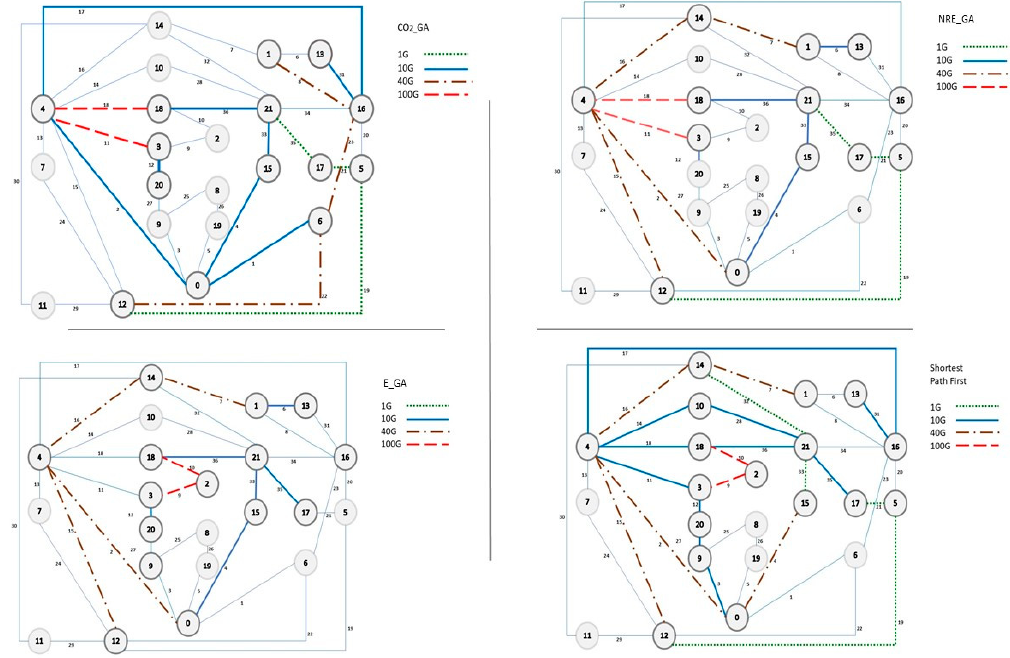
Figure 8. Topology for different algorithm. Table 4. Demand paths from node-5 to node-14.